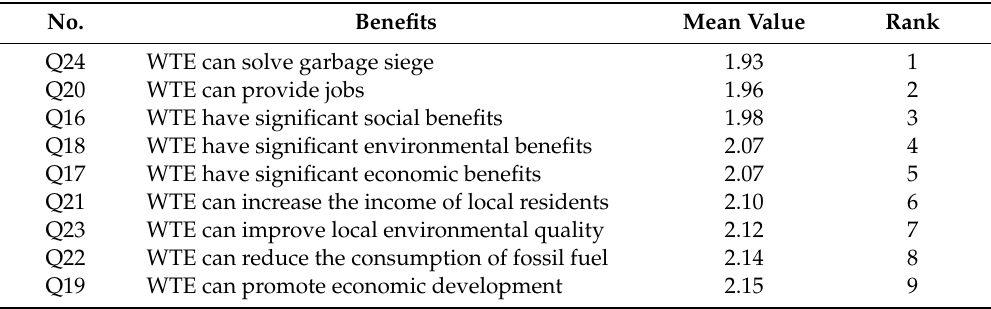
Table 7. The mean value of PB of WTE.